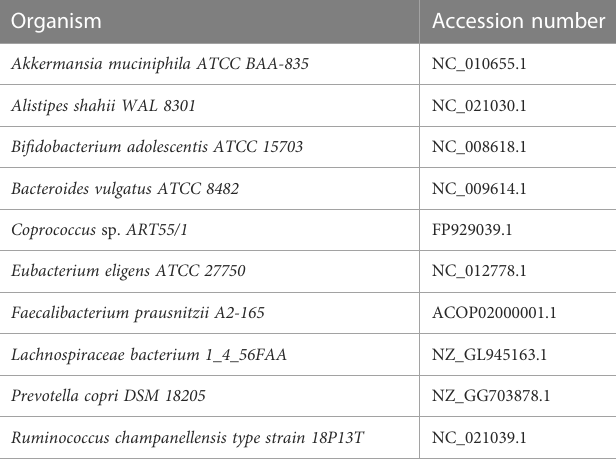
TABLE 1 Species and accession numbers used in dataset